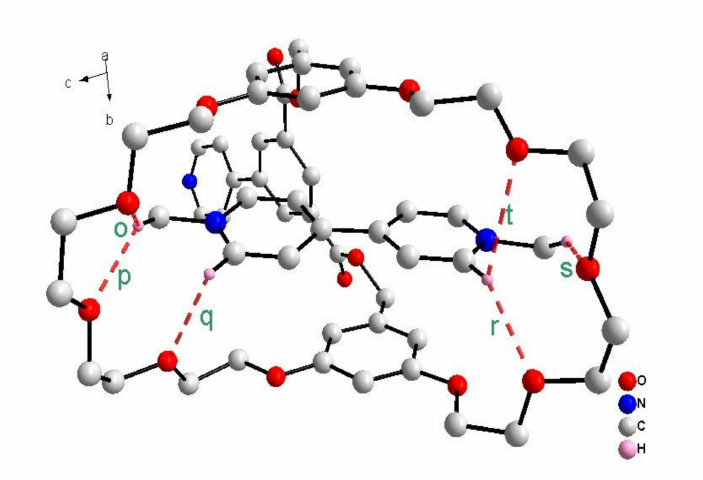
Figure 2. A ball-stick view of the X-ray structure of 4 ⊃ (cid:84) 6 . Counterions, solvent molecules, and hydrogens except the ones involved in hydrogen bonding are omitted for clarity. Hydrogen bond parameters: H ... O (N) distance (Å), C-H ... O (N) angle (deg) o, 2.536, 144.0; p, 2.475, 142.9; q, 2.803, 107.0; r, 2.431, 140.1; s, 2.469, 147.7; t, 3.012,